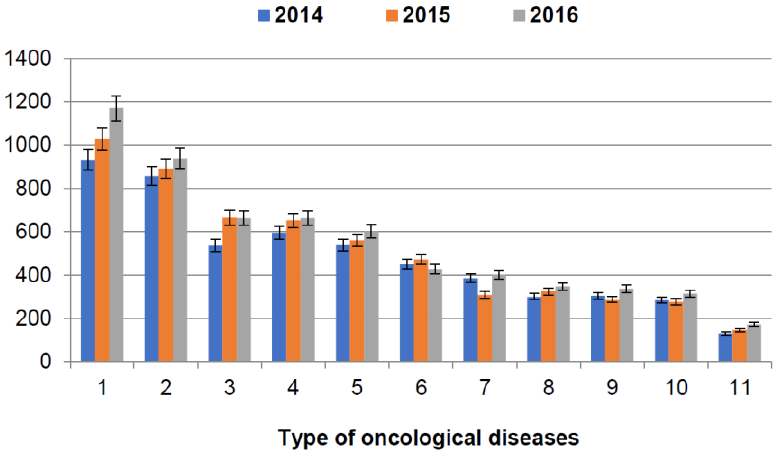
Figure 6. The structure of morbidity due to oncological diseases (absolute cases) in the period 2014 – 2016 in the Republic of Moldova; 1 — bronchopulmonary cancer, 2 — mammary gland, 3 — rectum,